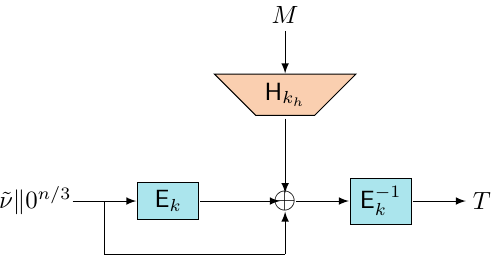
Figure 1.2: Decrypted Wegman-Carter with Davies-Meyer